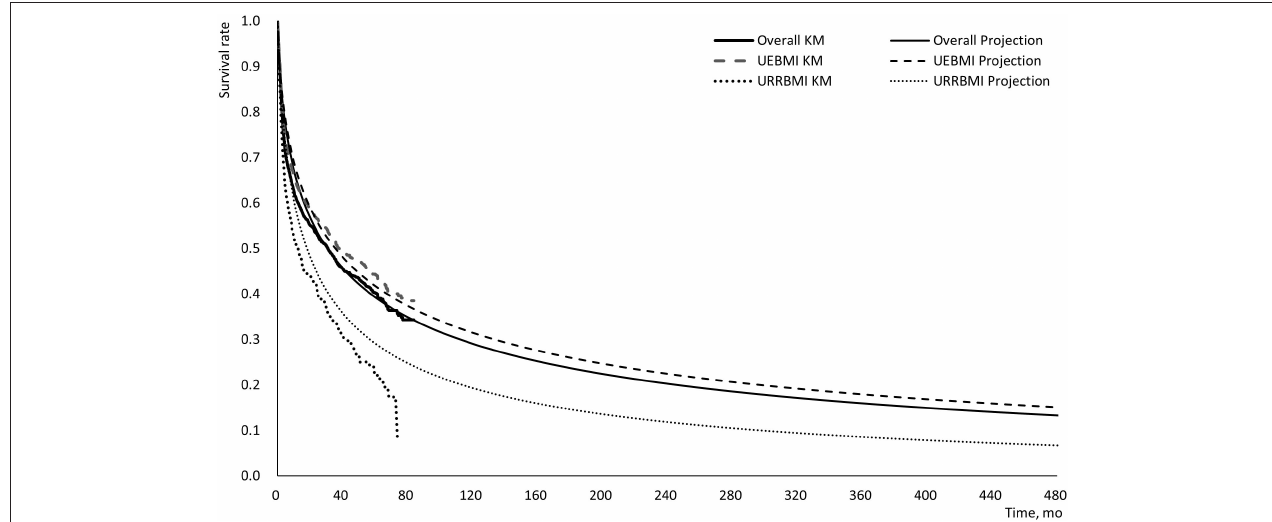
FIGURE 3 | Log-normal projection survival curves for patients with HCC during the lifetime. UEBMI, Urban Employee Basic Medical Insurance; URRBMI, Urban and Rural Resident Basic Medical Insurance; KM, Kaplan-Meier; HCC, hepatocellular